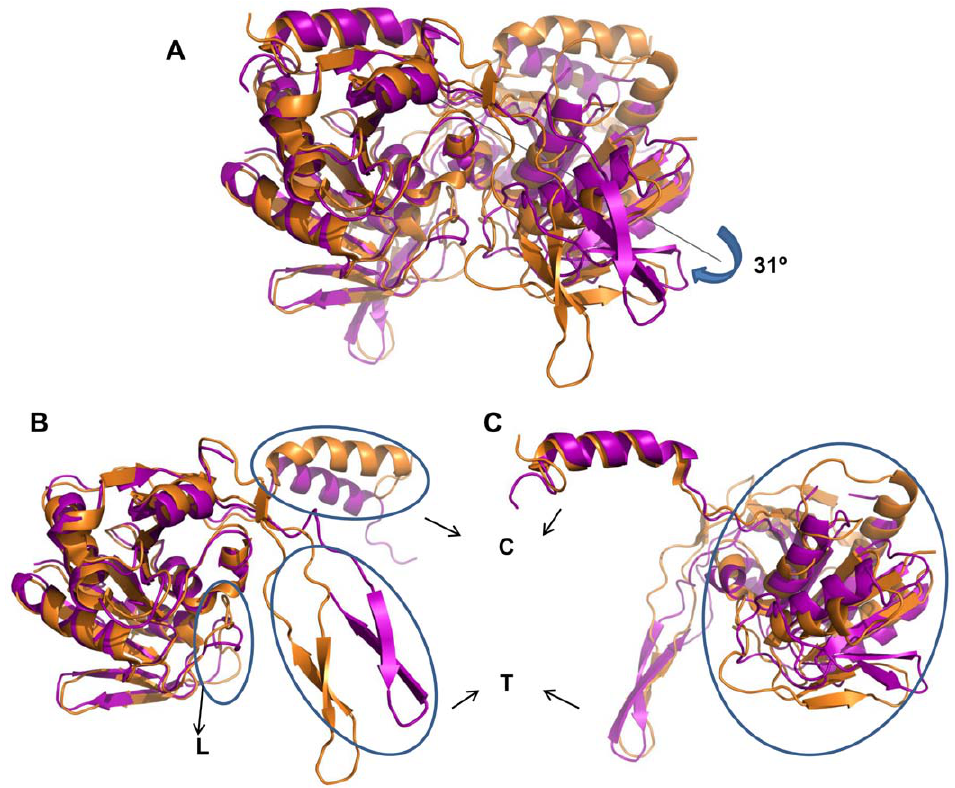
Figure 7. Comparison of the dimeric structure in wild type and mutant SurEs after structural alignment of A chains. A) Superposition of wild type (orange) and H234A (magenta) dimers using only A chain for structural alignment leaves 31 u difference in the orientation of B-subunits. A) is shown in two parts corresponding to A and B chains respectively in B) and C). The encircled regions denote the part of the protomer where the mutant structure has departed from the wild type structure. C, T and L denotes the C-terminal helices (residues 227–253), tetramerization loop (residues 179–210) and loop near active site (residues 39–51) respectively.